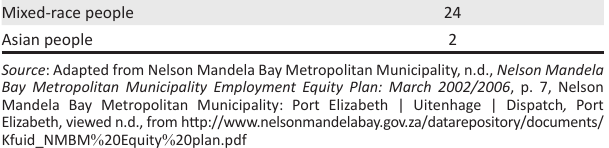
TABLE 1: Population of the municipality in the Nelson Mandela Bay Municipality. Race % Black people 56 White